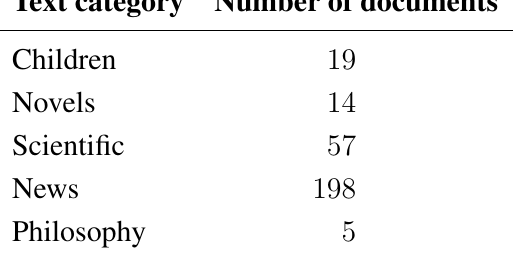
Table 5. Classes of analysed